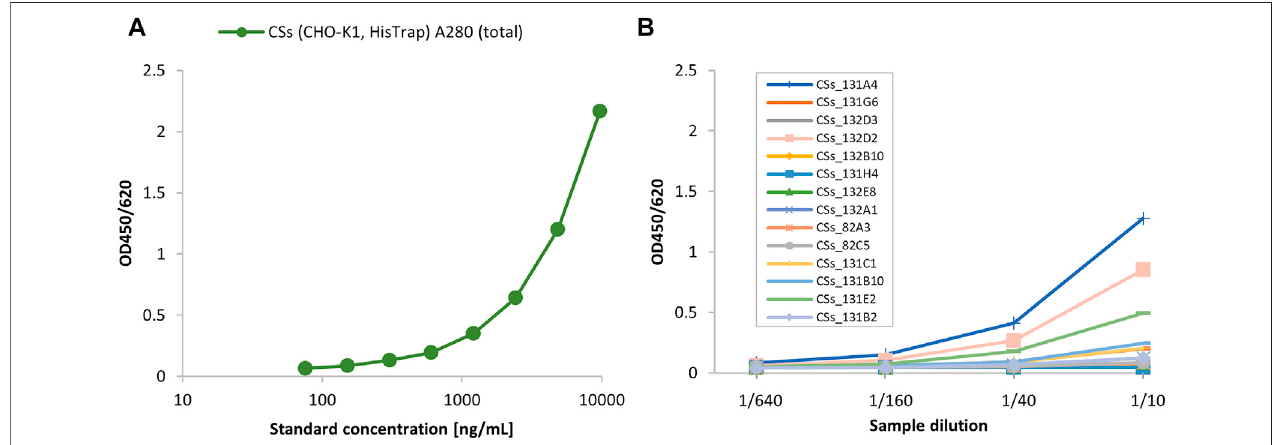
FIGURE 2 | Screening of various parental CSs subclones using the angiotensin-converting enzyme 2 (ACE2)/anti-His sandwich ELISA. The initially puri fi ed CSs material from the cell pool cultivation was used as ELISA standard (10 μ g/ml total protein by A280 absorbance) (A) to screen parental CSs subclones (B) .